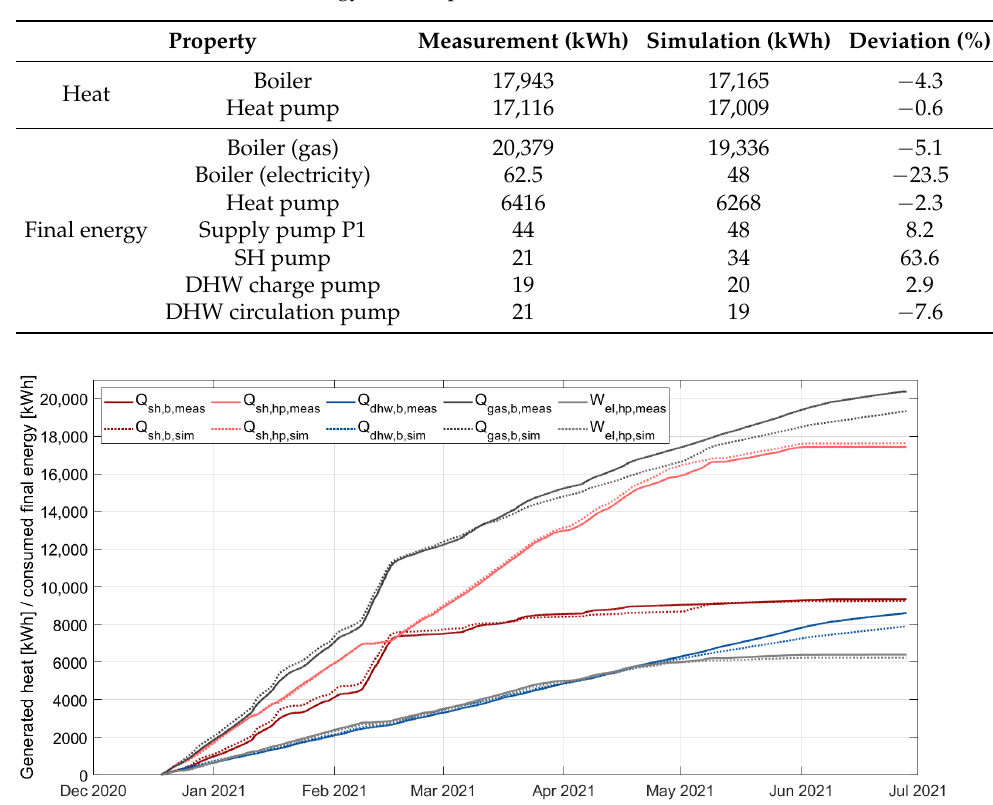
Figure 18. Comparison of measured and simulated provided heat for space heating and domestic hot water preparation and used final energy of both heat